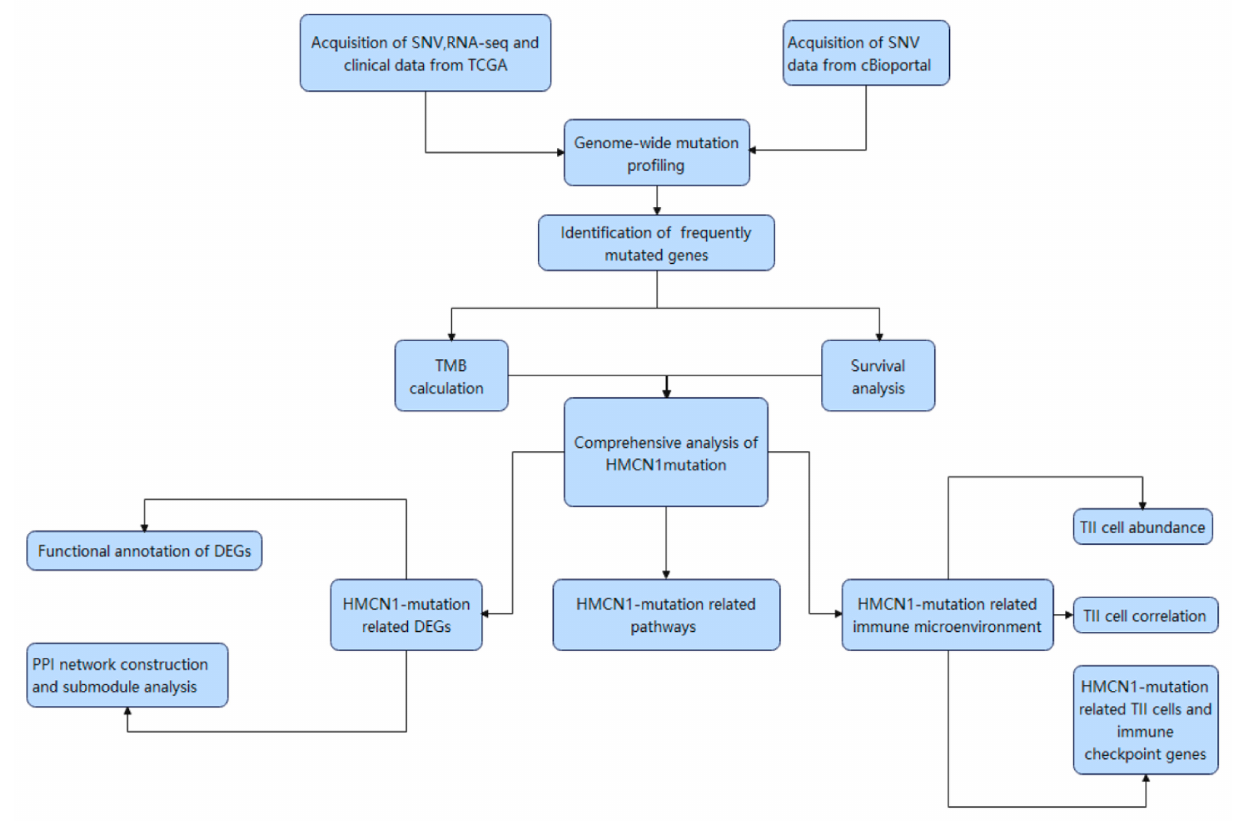
Figure 1. Workflow chart of the analysis process.